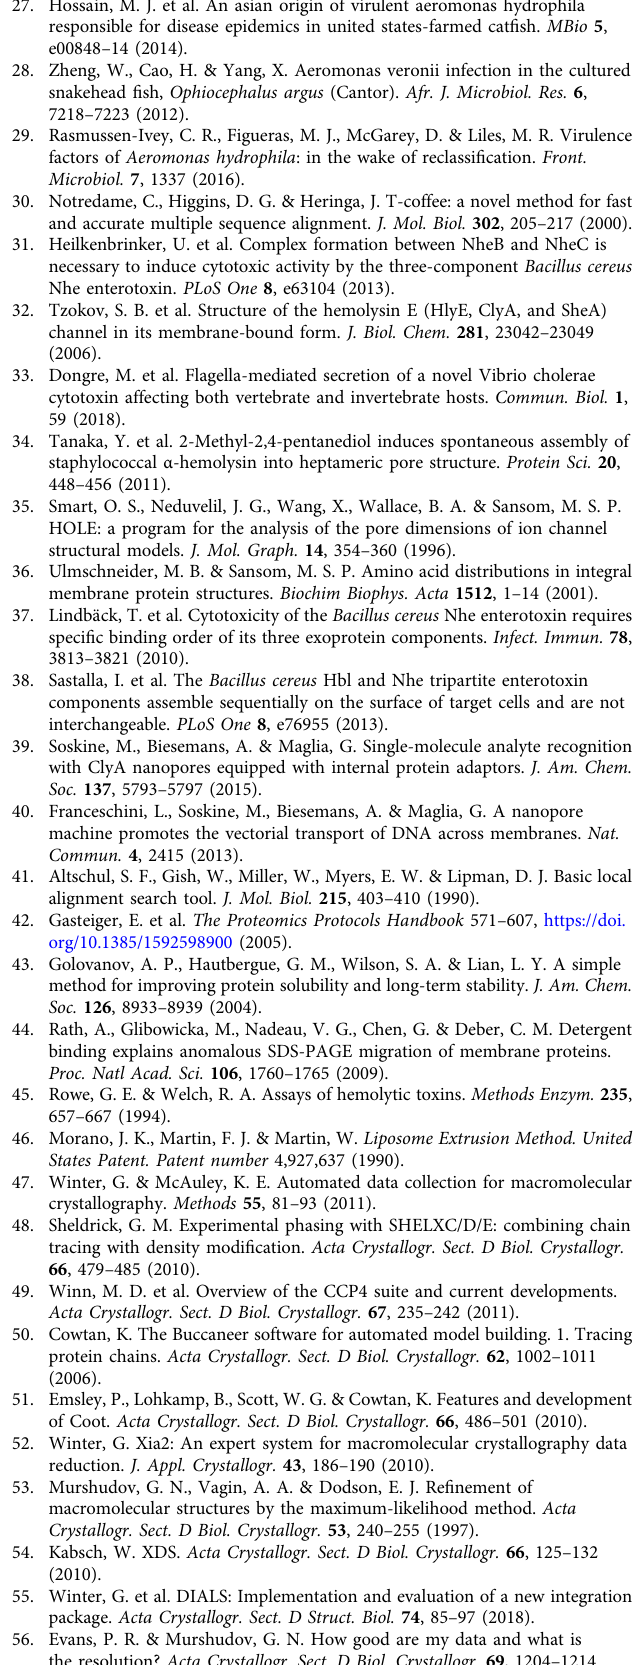
underlying Fig. 1a – d, f, g and Supplementary Figs. 3a, b and 11 are provided as a Source Data fi